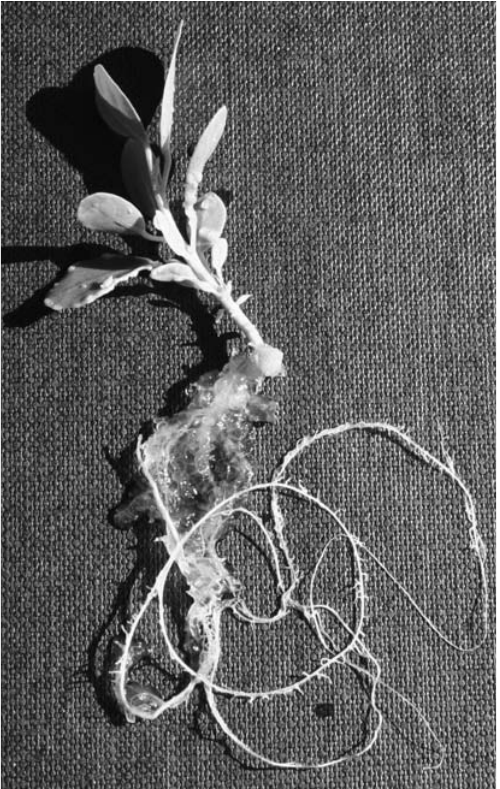
control.Fig. 4. Rooting of CapLV-free